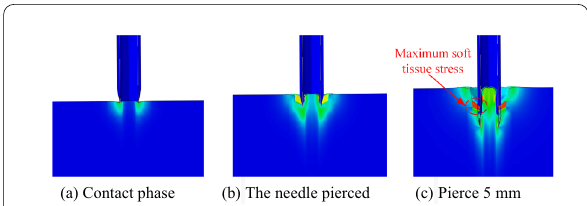
Figure 11 Stress changes at different puncture depths